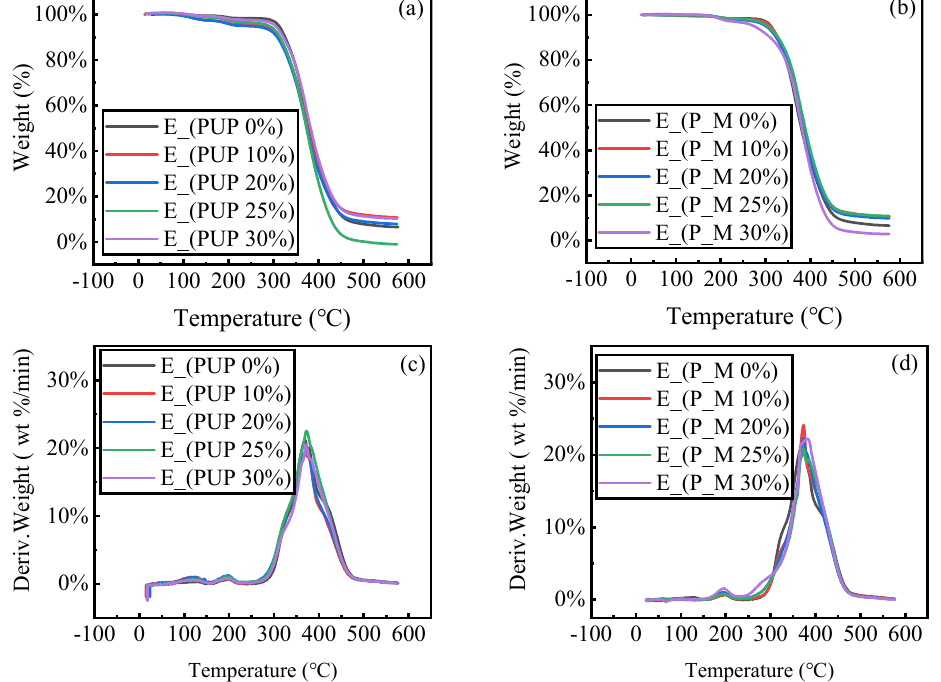
Figure 5. TG and DTG of the modified EP. ( a ) TG of PUP modified EP, ( b ) TG of P-M modified EP, ( c ) DTG of PUP modified EP, ( d ) DTG of P-M modified EP.